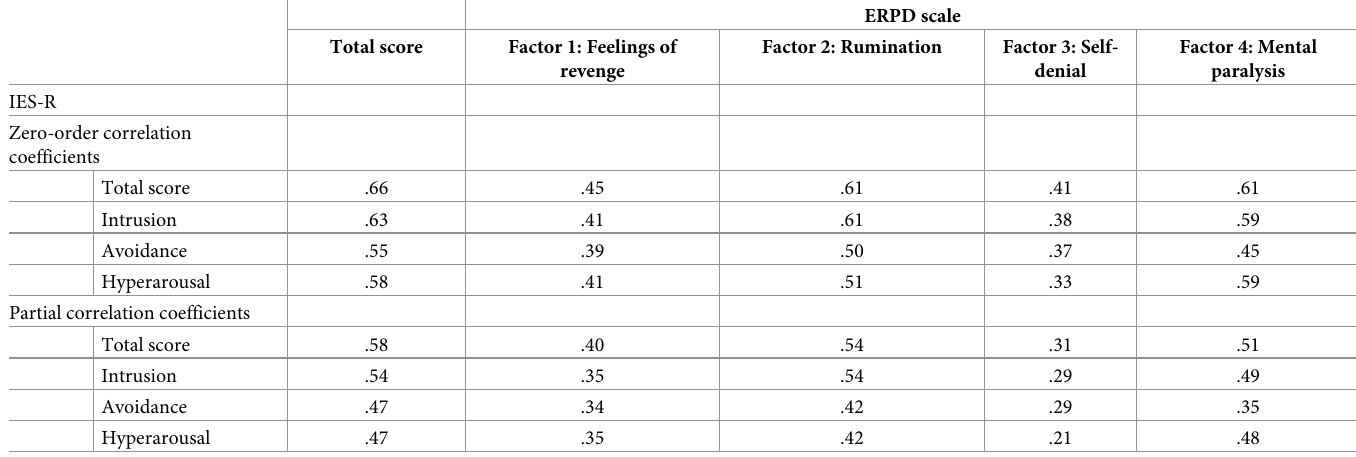
Table 4. Pearson’s correlation and partial correlation analyses between the ERPD scale and the